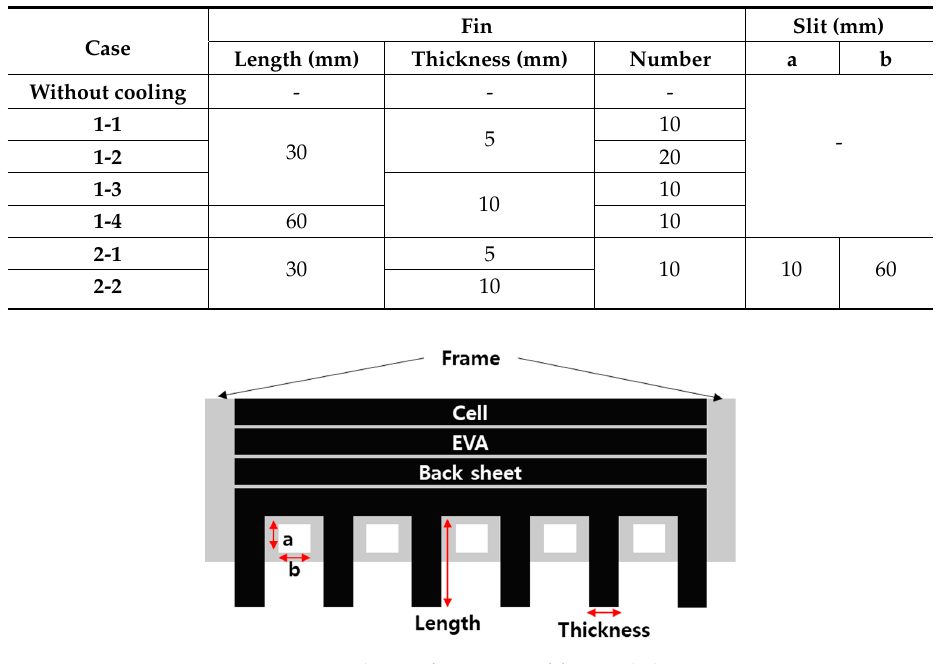
Figure 5. The configuration of fins and slits.